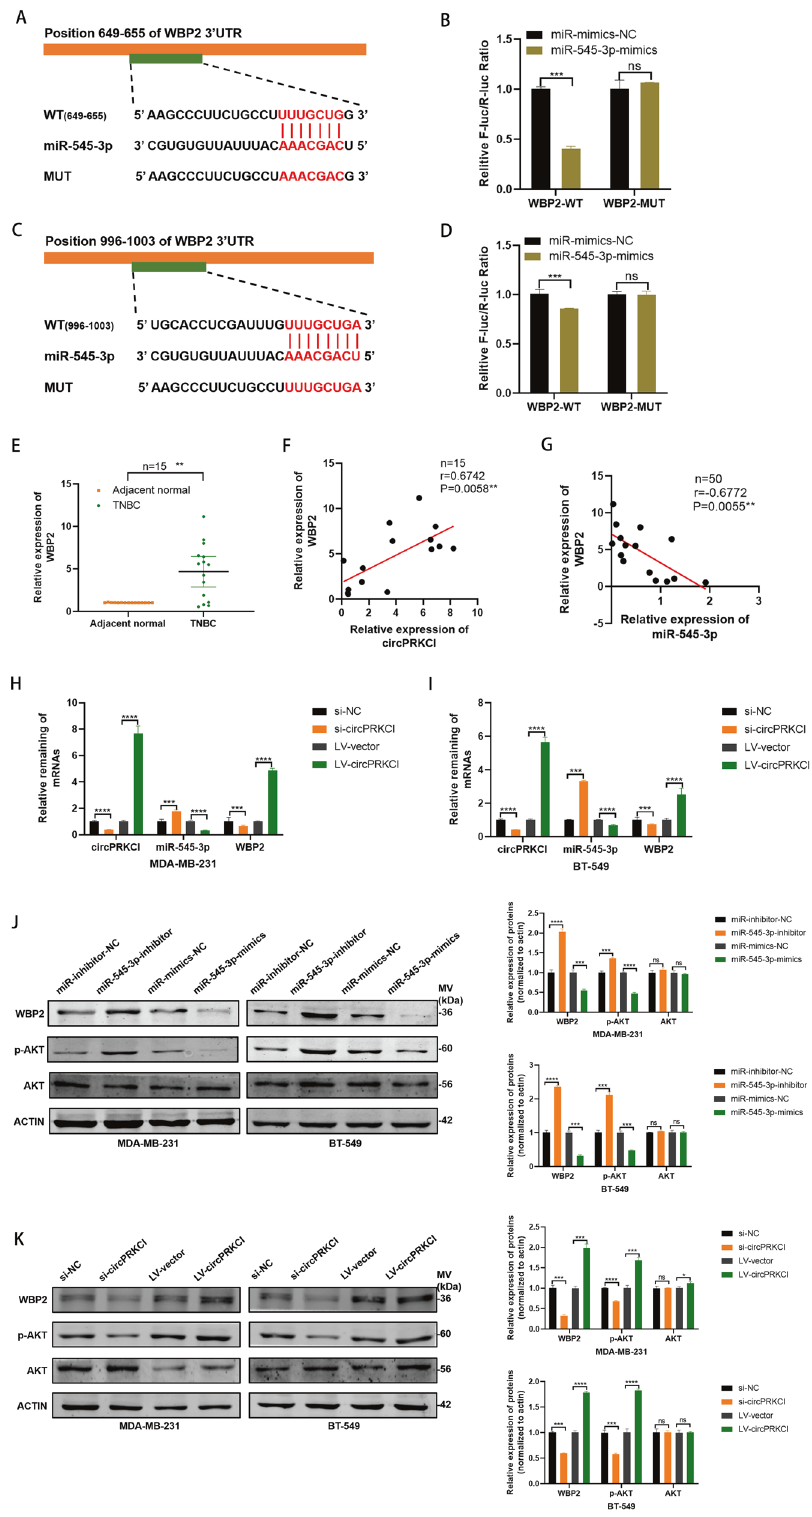
Fig. 5 WBP2 was a direct target gene of miR-545-3p. A , C Putative complementary sites within miR-545-3p and WBP2 predicted by bioinformatics analysis (TargetScan). B , D Dual luciferase reporter assays demonstrated that WBP2 is a direct target of miR-545-3p. E WBP2 had high expression in TNBC tissues compared with adjacent normal tissues. F Positive correlations between the expression of circPRKCI and WBP2 were found with Pearson ’ s correlation analysis in TNBC tissue samples ( n = 15). G Negative correlations between the expression of miR- 545-3p and WBP2 were found with Pearson ’ s correlation analysis in TNBC tissue samples ( n = 15). H – I The mRNA level of miR-545-3p and WBP2 were evaluated in TNBC cells transfected with si-circPRKCI and LV-circPRKCI. J The protein level of WBP2, AKT and p-AKT were evaluated in TNBC cells transfected with miR-545-3p-inhibitor or miR-545-3p-mimics. K The protein level of WBP2, AKT and p-AKT were evaluated in TNBC cells transfected with si-circPRKCI and LV-circPRKCI. * p < 0.05, ** p < 0.01,*** p < 0.001,**** p < 0.0001. Cell Death Discovery (2022)